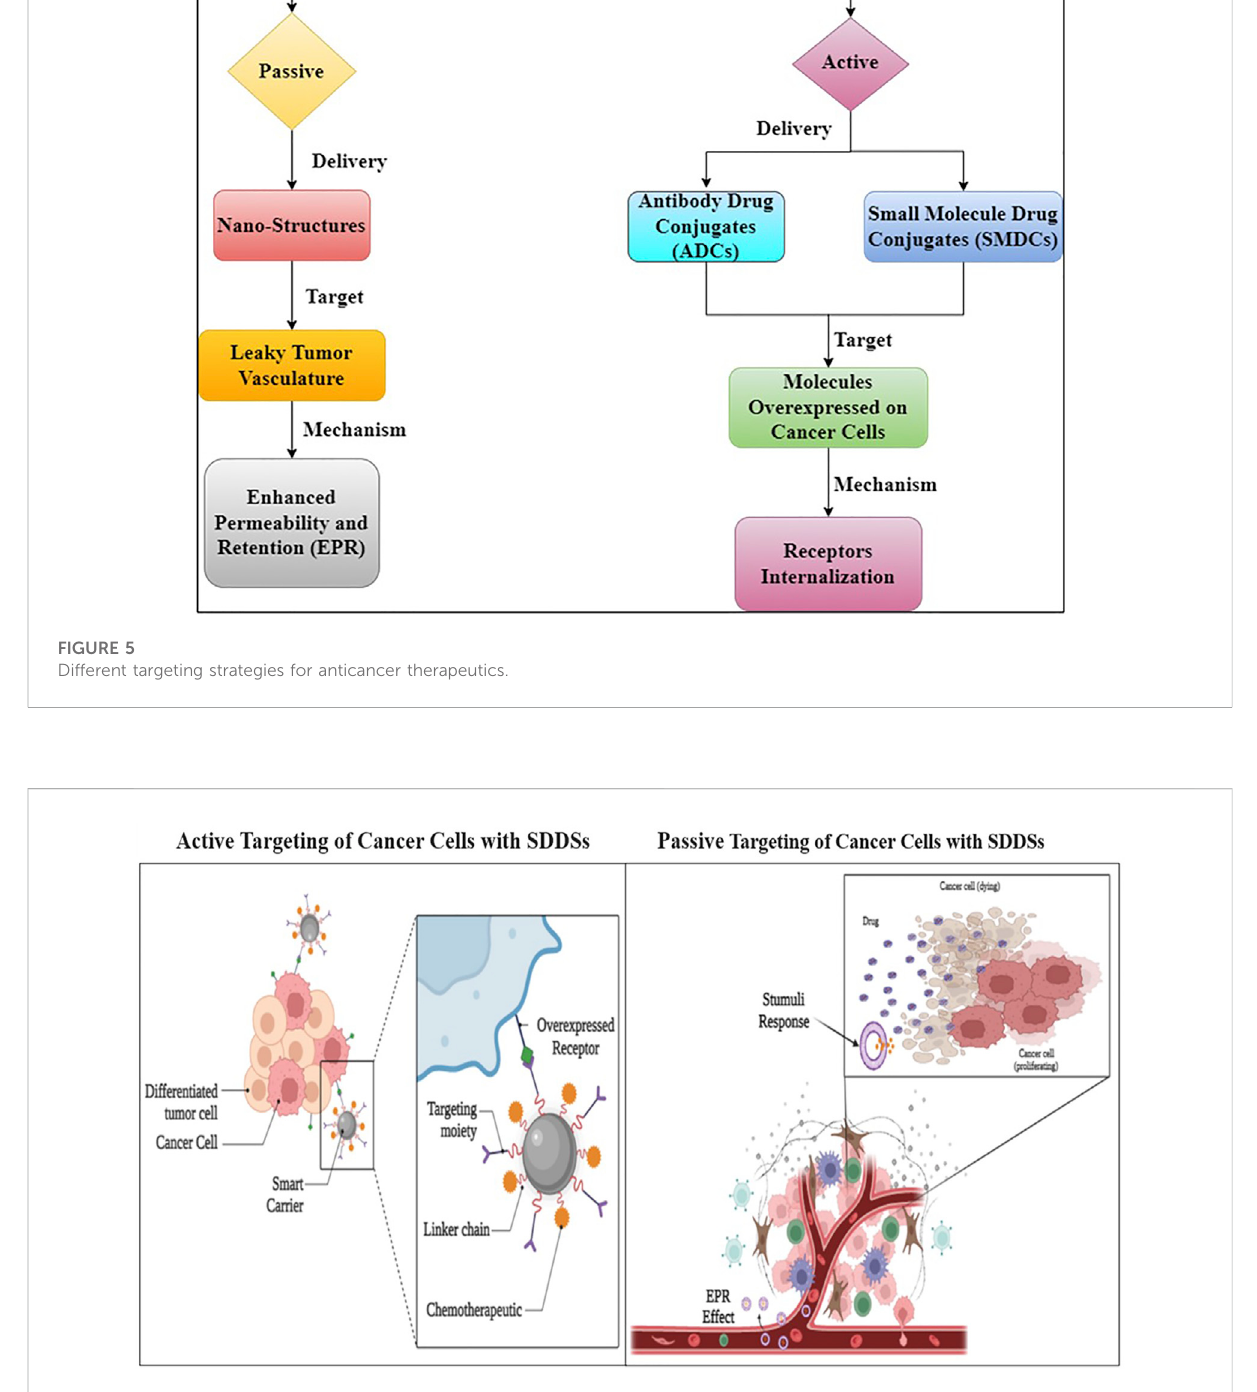
FIGURE 6 Active and Passive targeting delivery of drug payload by